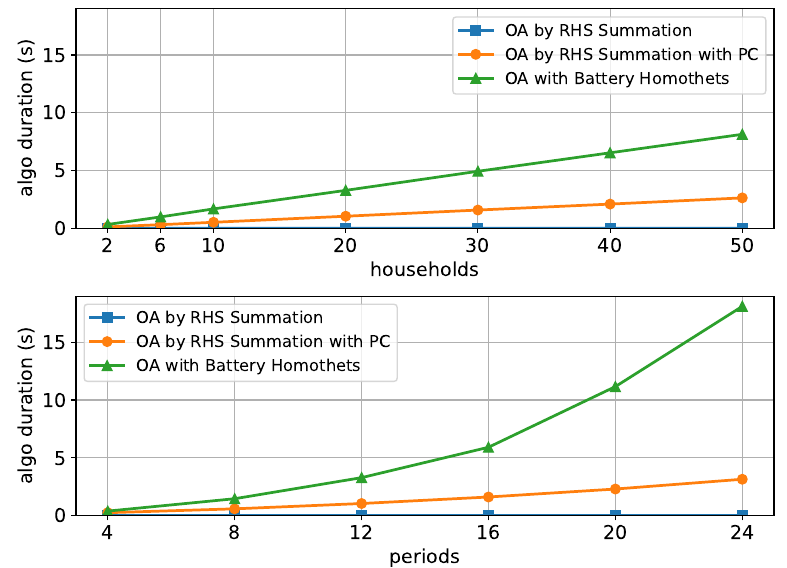
Figure 5. Time to calculate the approximation—( top ): computation time dependence on number of households for 12 periods; ( bottom ): computation time dependence on number of periods for 20